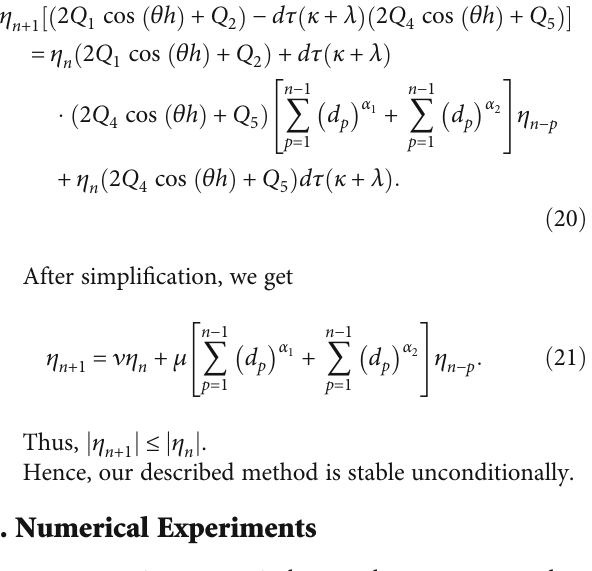
Table 6: The absolute error of Example 2 when N = 70 , α α = 0 : 2 , and τ = 0 : 5 for di ff erent values of γ . 2 f